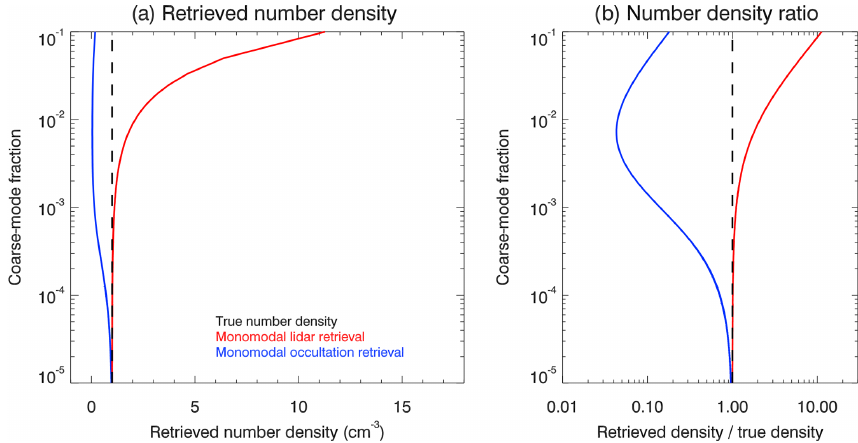
Figure 6. Similar to Fig. 3 but for aerosol number density.